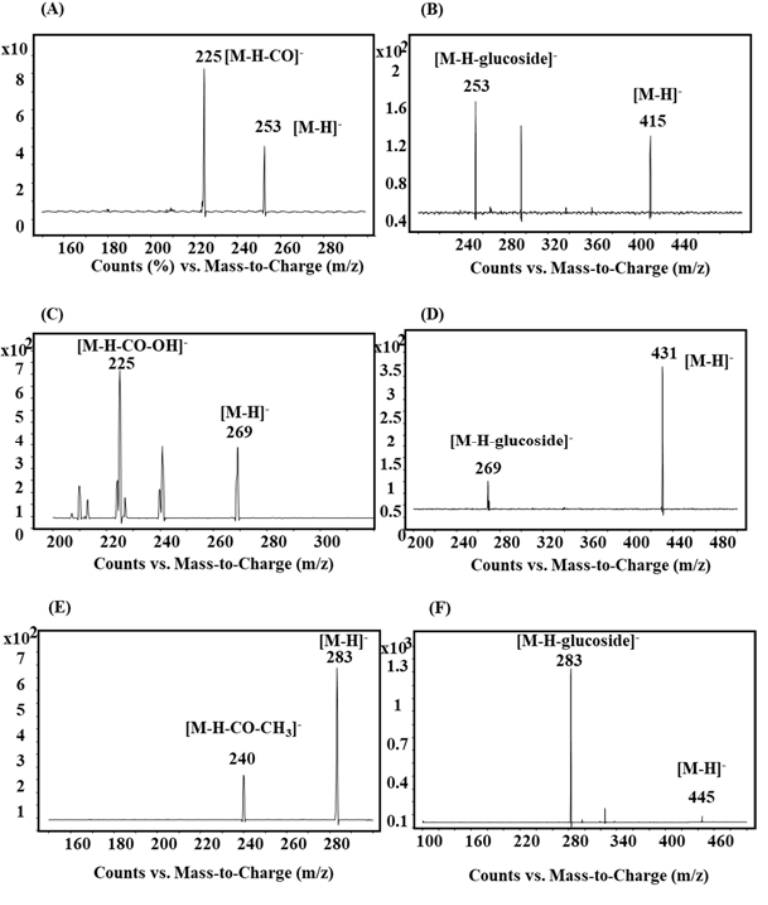
Figure 2. MS/MS scan spectra of six anthraquinones. ( A ) chrysophanol; ( B ) chrysophanol ‐ 8 ‐ O ‐β‐ D ‐ glucoside; ( C ) emodin; ( D ) emodin ‐ 8 ‐ O ‐β‐ D ‐ glucoside; ( E ) physcion; ( F ) physcion ‐ 8 ‐ O ‐β‐ D ‐ glucoside.